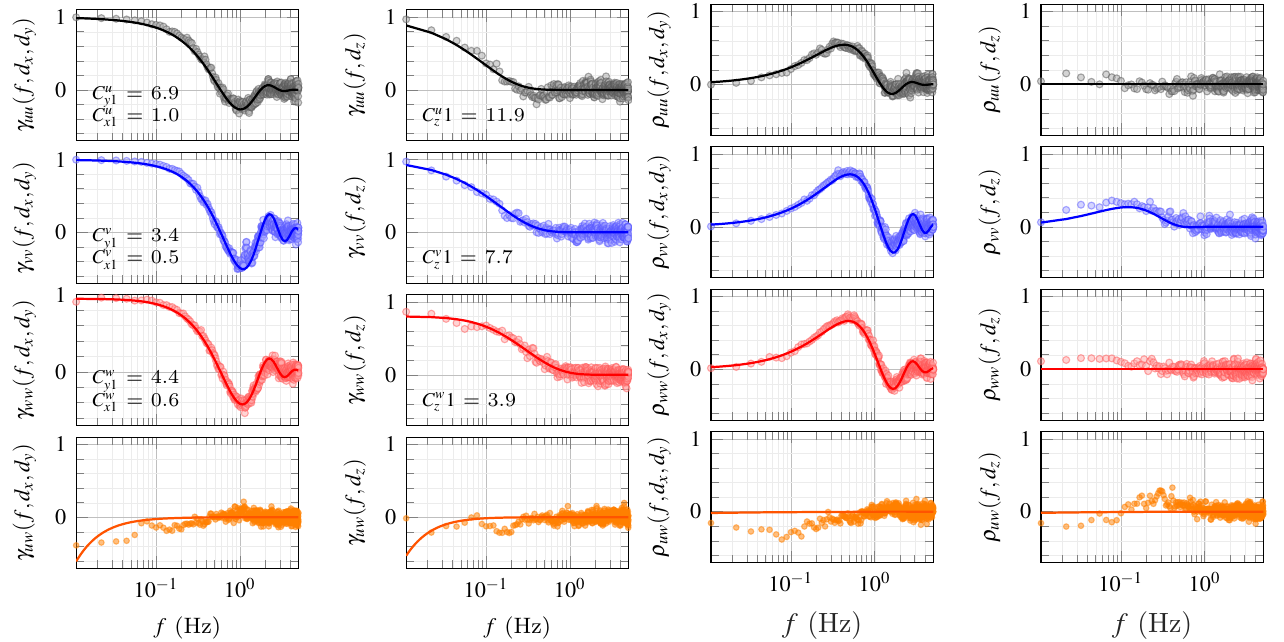
Figure 6. Co-coherence and quad-coherence of the three velocity components estimated for a wind direction of 331°, u = 18ms − 1 at z = 49 m above ground and a yaw angle of 69° ( d x = 7.5 m, d y = 2.9 m, and d z = 16 m). The data were recorded on 8 December 2017 from 20:00 to 23:00. The solid lines correspond to the best fit of Equation (32) for the co-coherence and Equation (33) for the